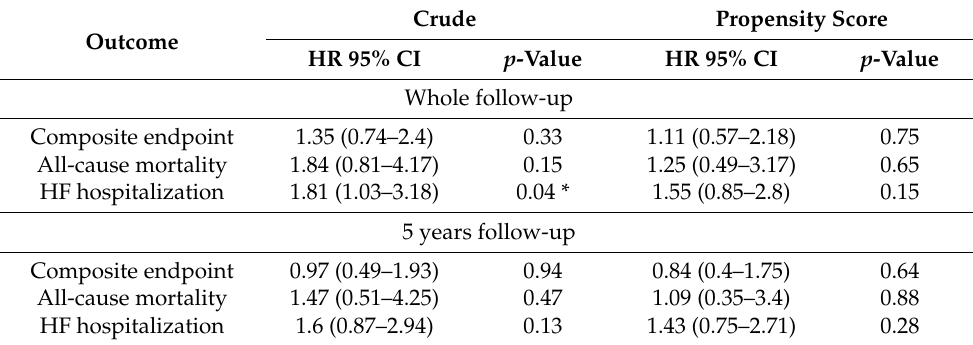
Table 4. Crude and adjusted hazard ratios of the study endpoints.